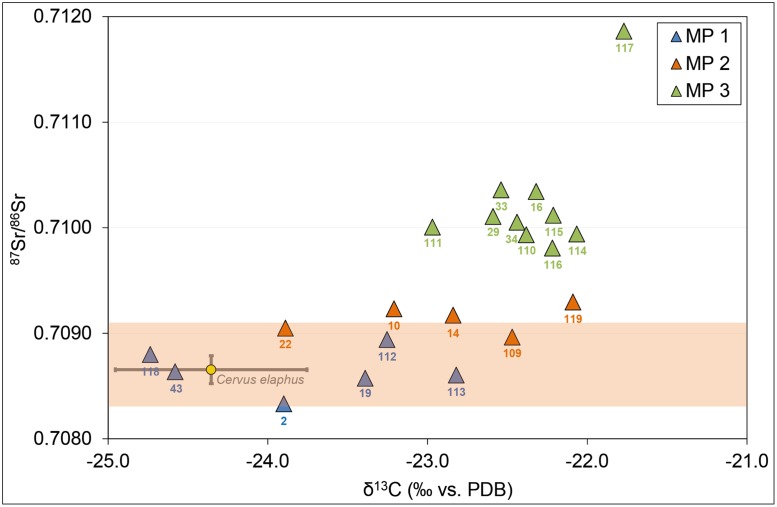
Scatter plot of δ13C values of cattle bone collagen and average 87Sr/86Sr data of tooth enamel.δ13C and 87Sr/86Sr (mean of all intra-tooth measurements for an individual) data for cattle (Bos taurus) are given in Table 1. Sample ID’s are indicated (excl. ARB). Red deer (Cervus elaphus) isotopic data (n = 6; 1σ standard error) are also provided for comparison. The grey bar represents the local 87Sr/86Sr range (0.7083–0.7091).